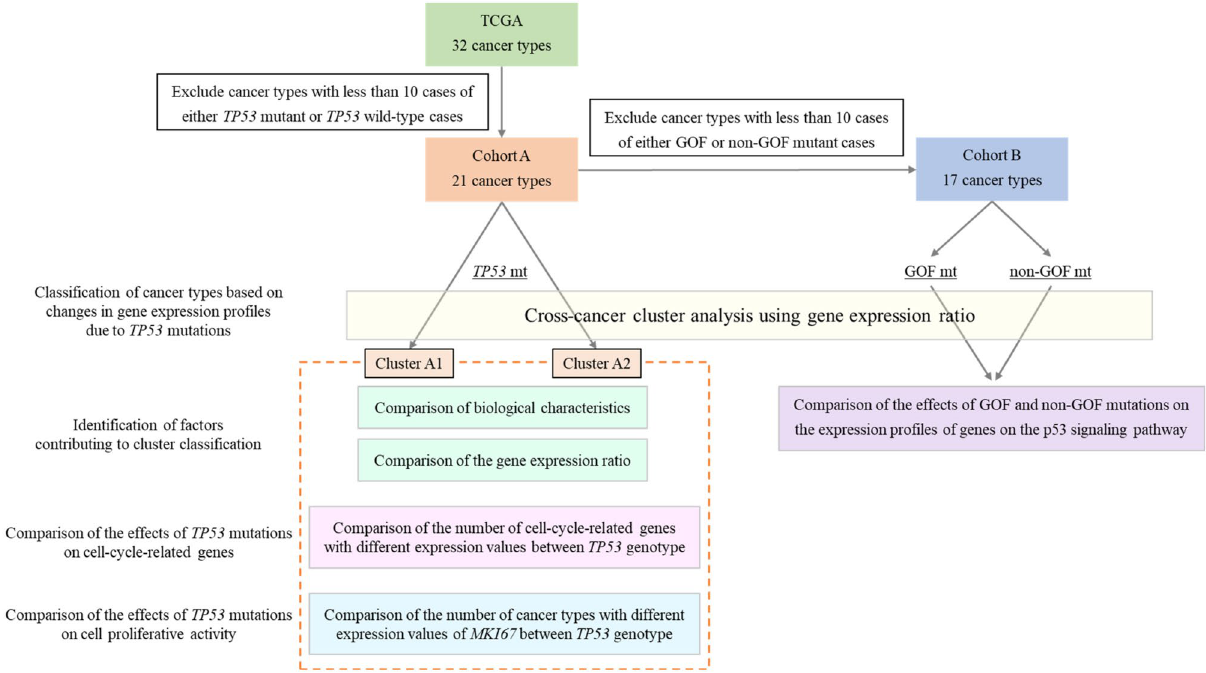
Figure 1. The workflow of analyses. TCGA, The Cancer Genome Atlas; TP53 mt, TP53 mutation; TP53 wt, TP53 wild-type; GOF mt, TP53 gain-of-function mutation; non-GOF mt, TP53 non-gain-of-function